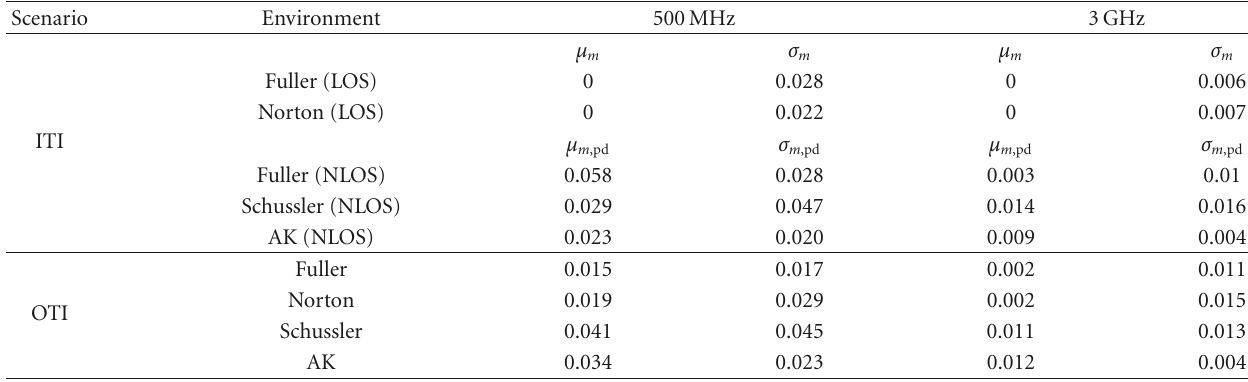
Table 3: Gaussian distribution modeling parameters of the normalized ranging error. Subscripts denote the source of the ranging error.